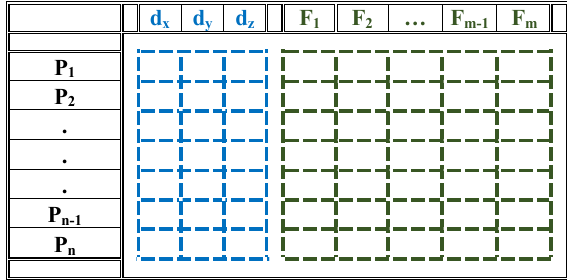
Table 2. Input data matrix representation for DL applications: each row represents the 3D points, (dx,dy,dz) represents PWDC, F m represents extracted